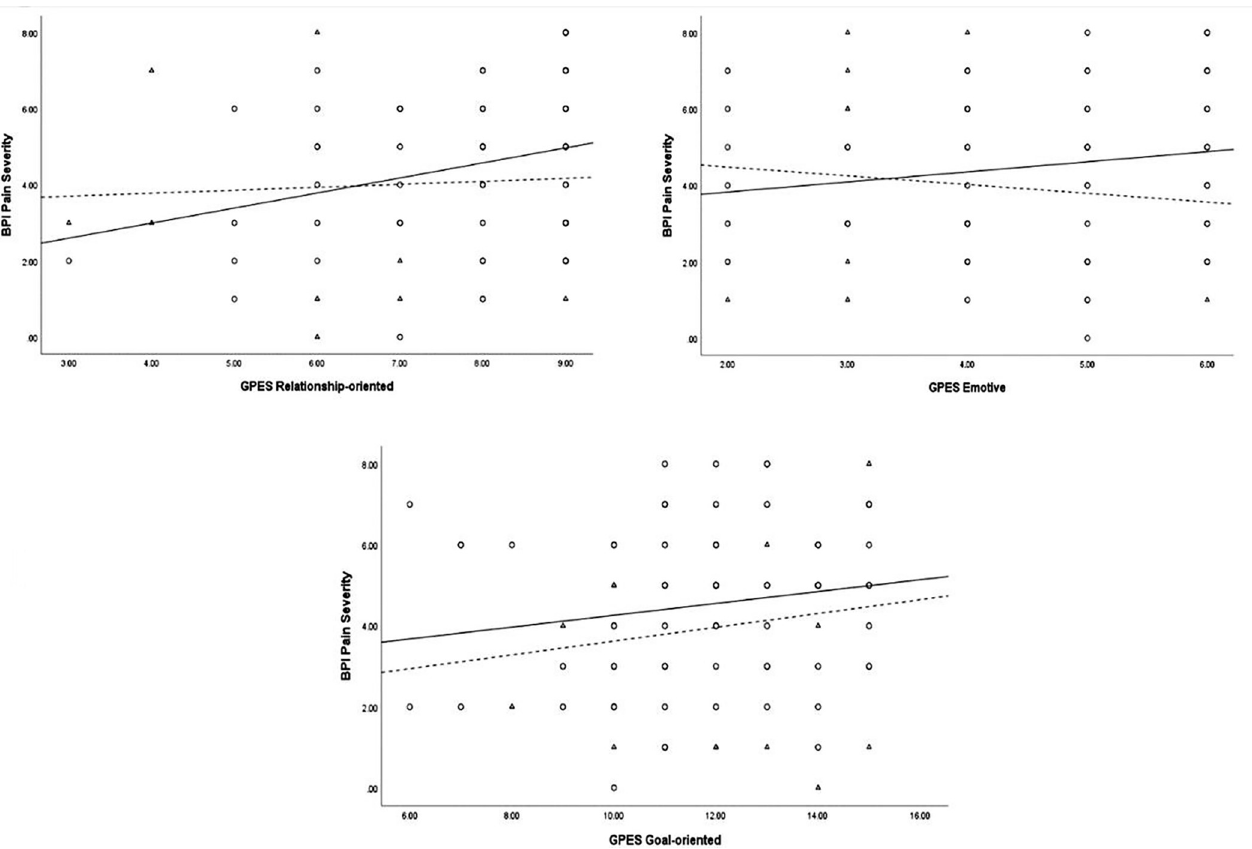
Fig 1. Scatter plot of the relationship between BPI Pain Severity and Relationship-oriented, Emotive, and Goal-oriented subscales in males and females. ( � ) and ( ⚊ ) represent Females; ( Δ ) and ( ⚋ ) represent Males.